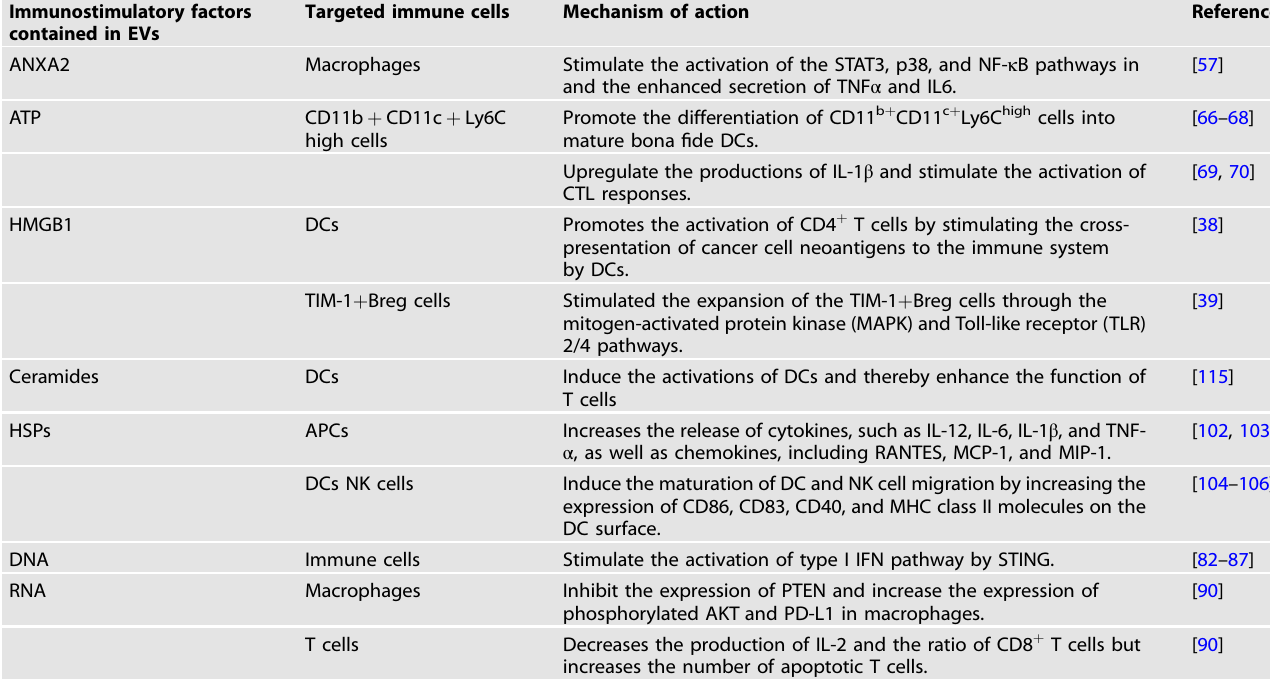
Table 1. Regulation of immune responses by immunostimulatory factors contained in EVs. Immunostimulatory factors contained in